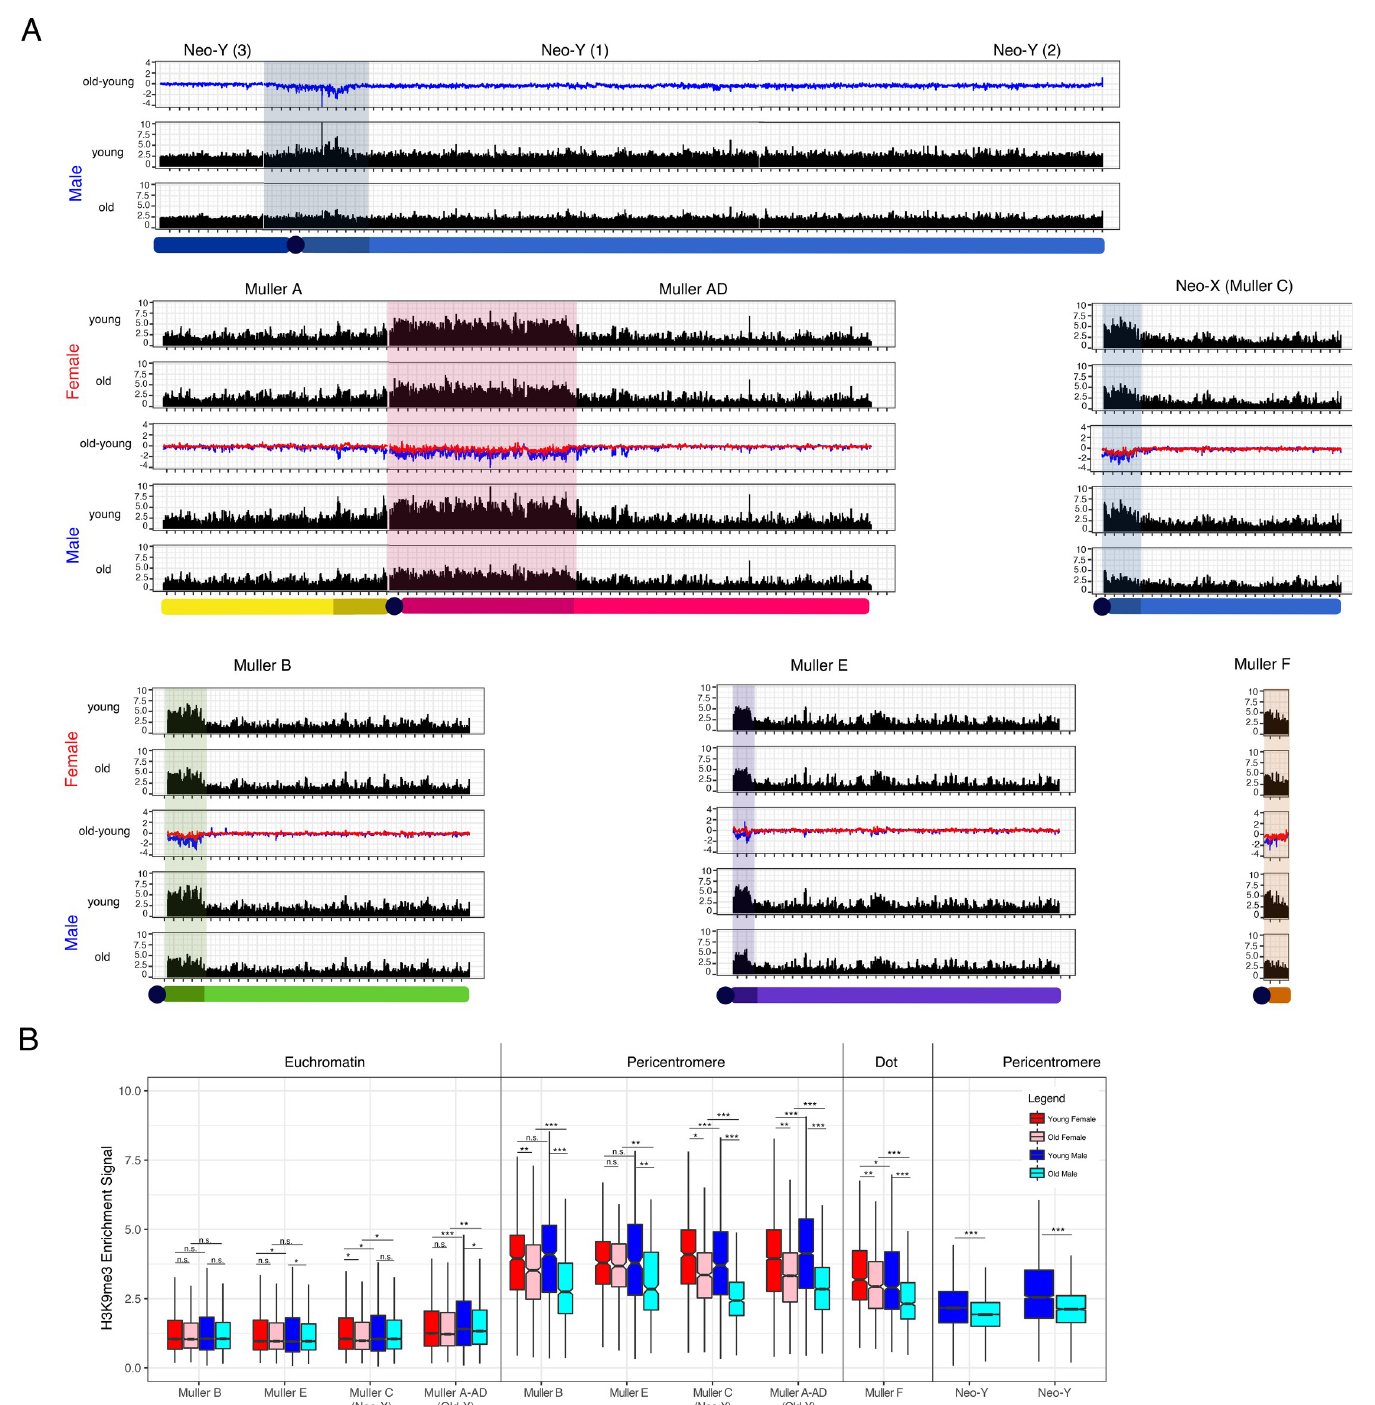
Fig 2. Heterochromatin loss and aging. A. Genome-wide enrichment of H3K9me3 for young and old D . miranda males and females along the different chromosome arms. Values represent the mean of 4 biological replicates for Young/Old Females and Young Males and the mean of 3 biological replicates for Old Males in 25kb windows. Subtraction plots show the absolute difference in signal of 25kb windows between young and aged flies along the chromosome arms, with females in red and males in blue. One tick mark is equal to 1 Mb on the x-axis. B. Boxplot showing ChIP enrichment differences between biological samples at euchromatin and pericentromeres. Enrichment resolution is in 5kb windows. Significance values calculated ( � p < 0.05, �� p < 1e-6, ��� p < 1e-12, Wilcoxon test) for males (blue, cyan) and females (red, pink), with pericentromere boundaries defined by [24].